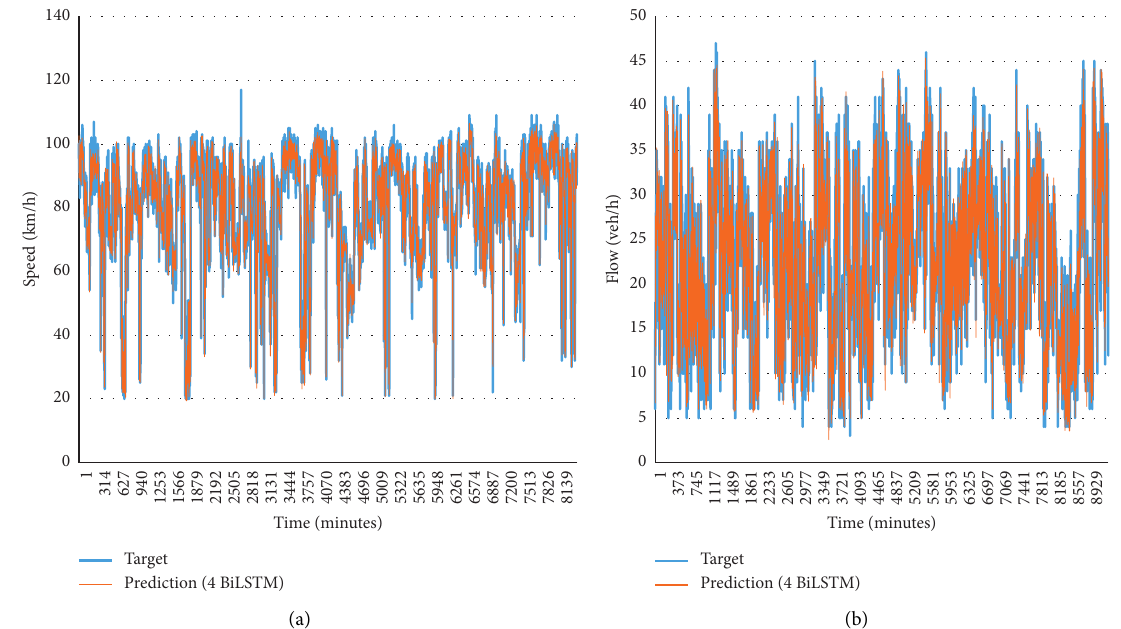
Figure 8: Tullamarine Freeway speed and flow prediction results for 15-minute horizons using the 4-BiLSTM model.